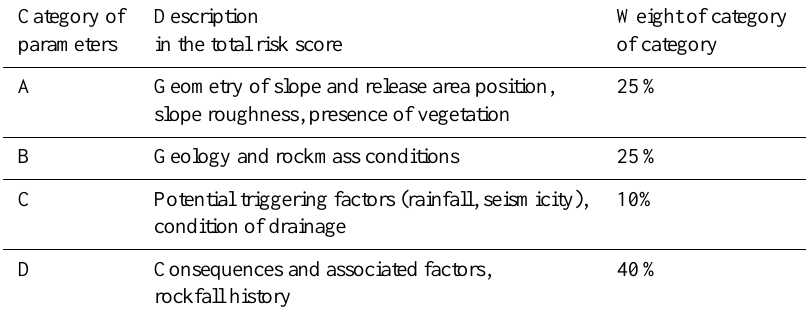
Table 3. Categories of parameters defining the risk and weight of each category. Category of Description Weight of category parameters in the total risk score of category A Geometry of slope and release area position, 25% slope roughness, presence of vegetation B Geology and rockmass conditions 25% C Potential triggering factors (rainfall, seismicity), 10% condition of drainage D Consequences and associated factors, 40% rockfall